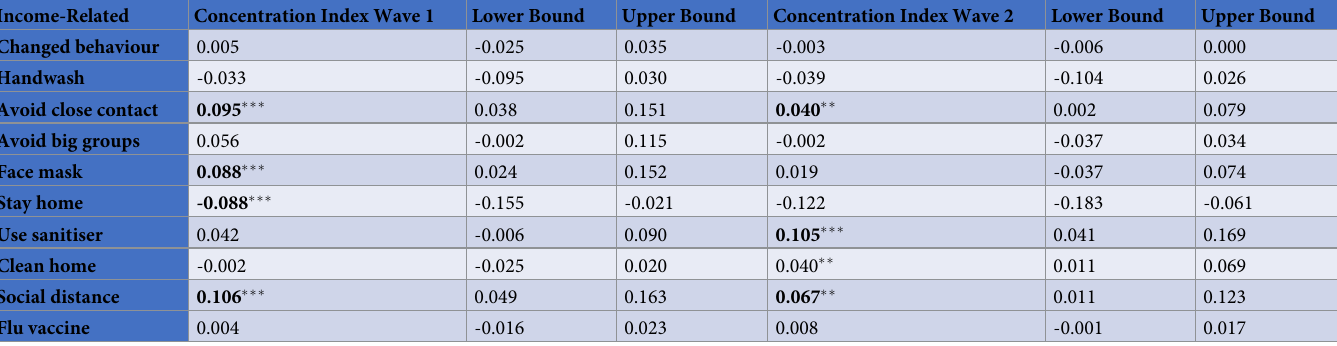
Table 2. Erreygers’-corrected concentration index (income-related) of preventive